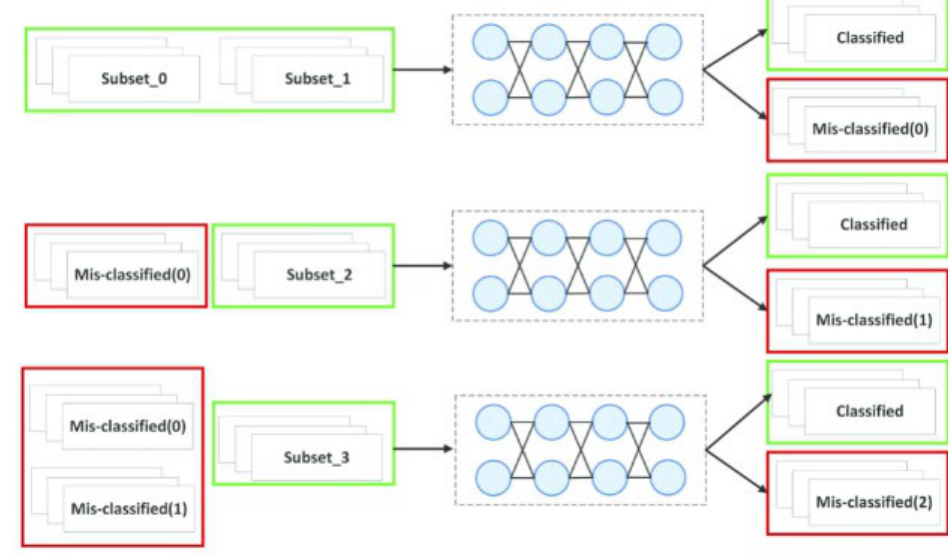
Figure 4. Weighted boosting methodology’s framework.